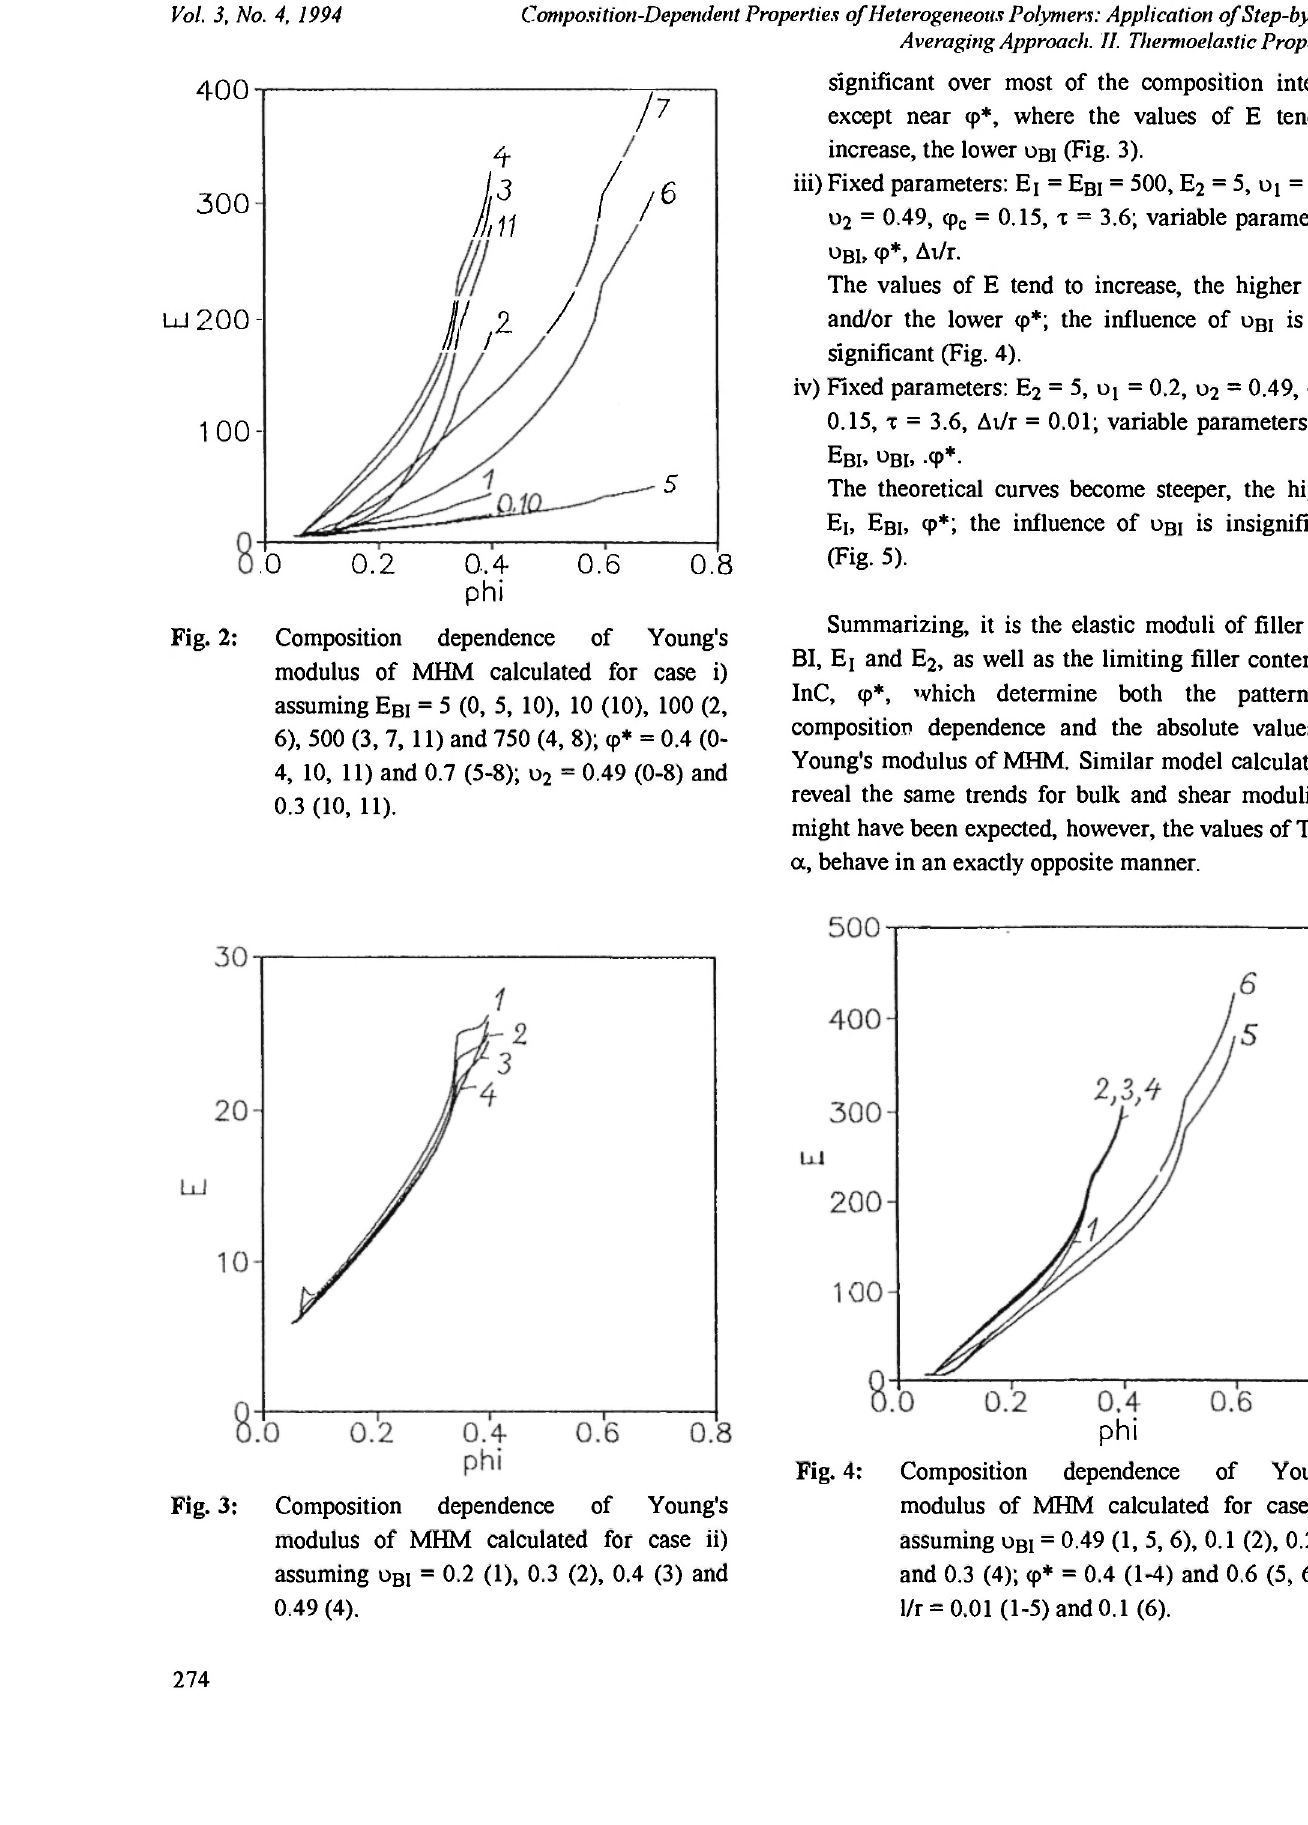
Fig. 4: Composition dependence of Young's modulus of MHM calculated for case iii) assuming υ Β ι = 0.49 (1, 5, 6), 0.1 (2), 0.2 (3) and 0.3 (4); φ* = 0.4 (1-4) and 0.6 (5, 6); Δ 1/r = 0.01 (1-5) and 0.1